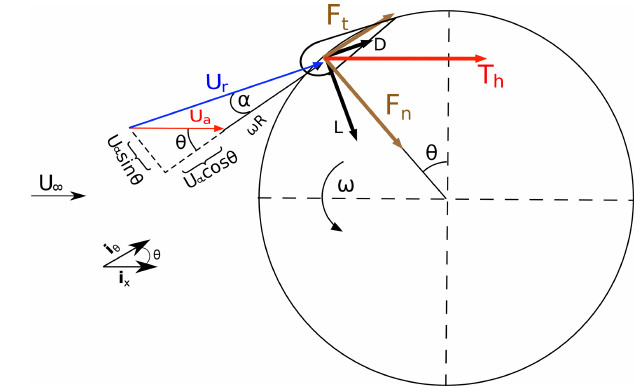
Figure 3. Velocity and force diagram on a top-down view of a VAWT